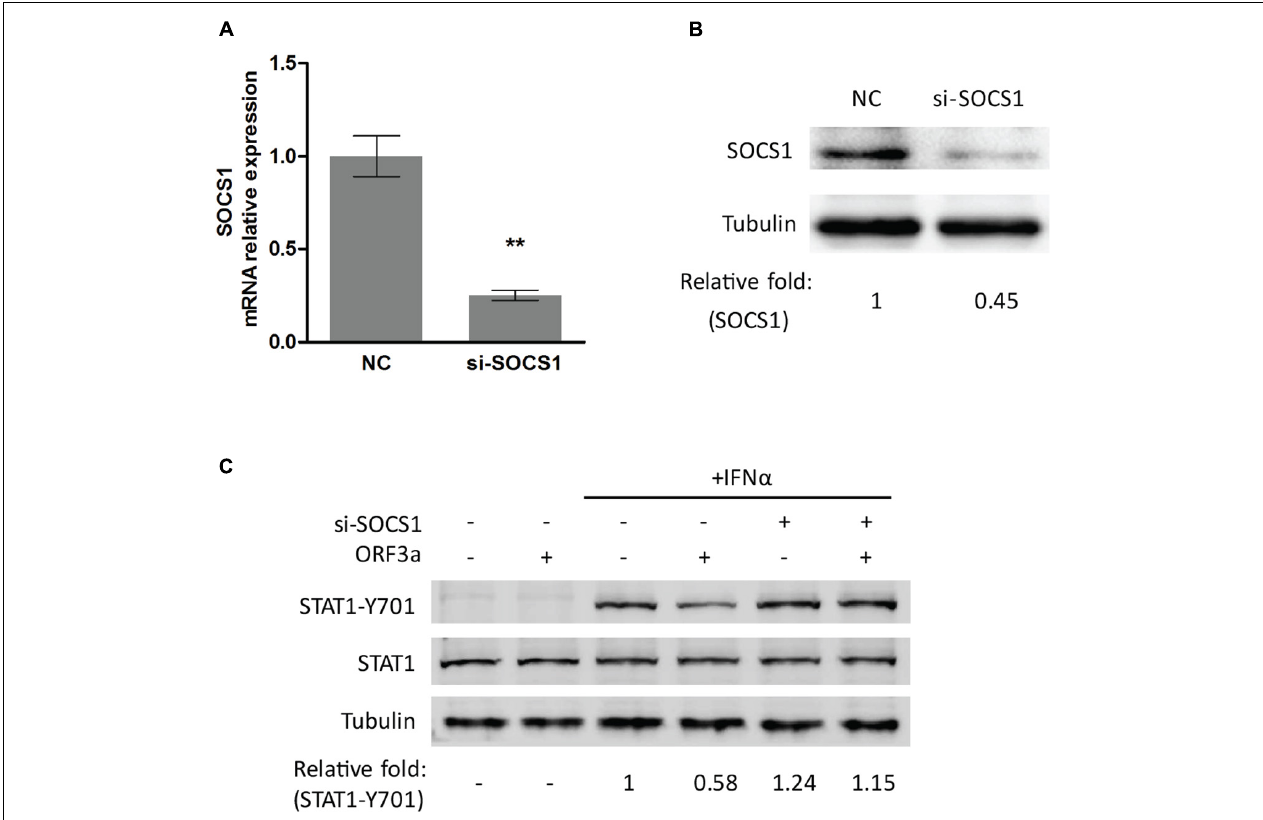
FIGURE 4 | Silencing of SOCS1 abolishes the inhibitory effect of ORF3a on IFN signaling transduction. (A,B) SOCS1 mRNA and protein levels in cells transfected with siRNA control (NC) or siRNA against SOCS1 (si-SOCS1). HEK293T cells were transfected with NC or si-SOCS1 (100 nM). Forty-eight hours later, the cells were harvested for RT-qPCR (A) and immunoblotting (B) . Significant differences from the NC-transfected control cells are denoted by “**”, which indicates P < 0.01. (C) Silencing of SOCS1 restored the STAT1 activation in cells transfected with ORF3a. Cells were cotransfected with empty vector or ORF3a plasmid along with NC or si-SOCS1. At 48 h after transfection, the cells were stimulated with IFN α for 0.5 h and then harvested for immunoblotting with antibodies against STAT1-Y701, STAT1, and tubulin. Relative levels of proteins are shown as folds below the images after normalization with